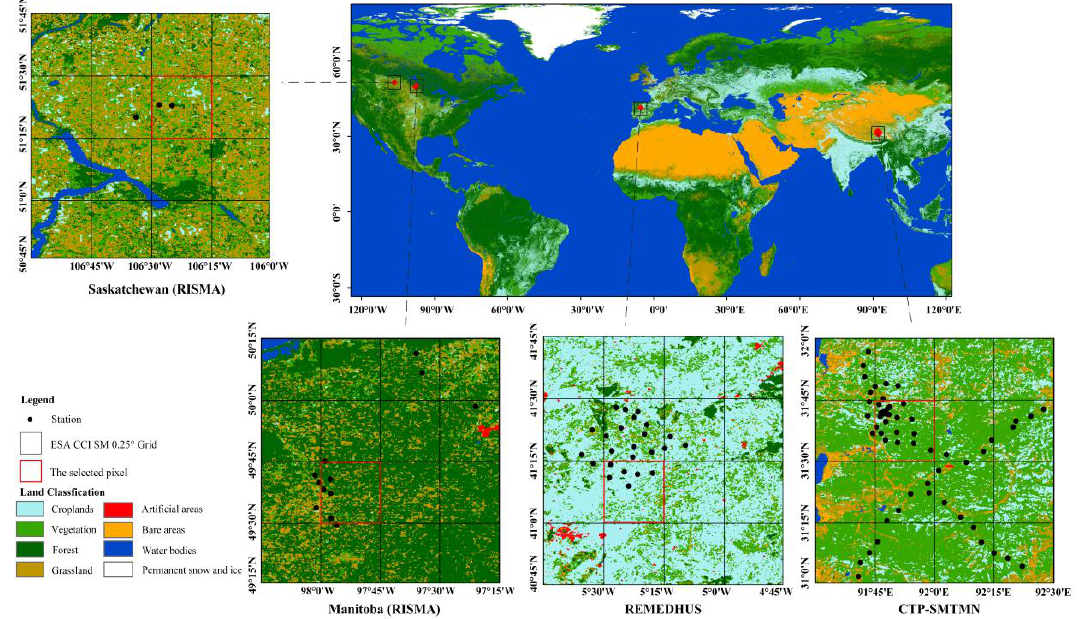
Figure 1. Locations of Climate Change Initiative (CCI) pixels, soil moisture ground measurements and land covers across study areas.